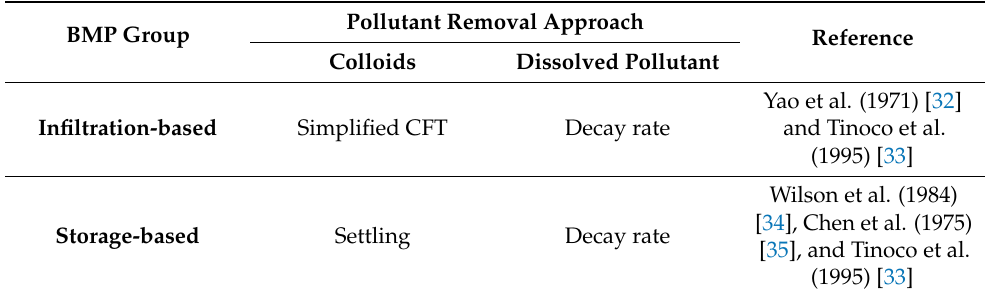
Table 1. Sizing approaches for different best management practice (BMP) groups by pollutant types. BMP